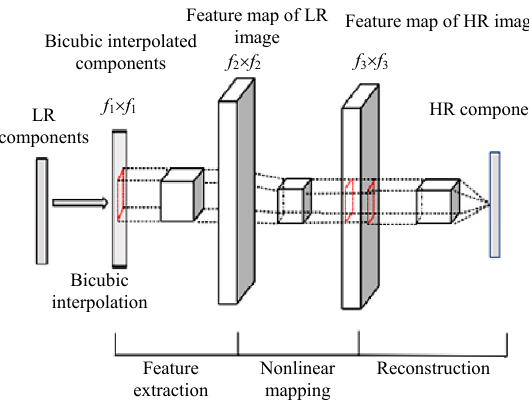
Fig. 2 General framework of the SRCNN